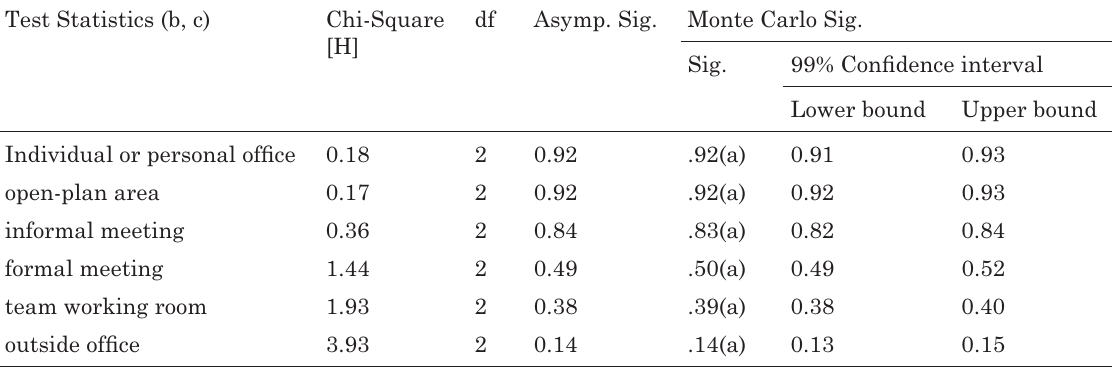
Flexible Working in Scottish Local Authority Property Table 4. Kruskal Wallis test of working-time spending Test Statistics (b, c) Chi-Square